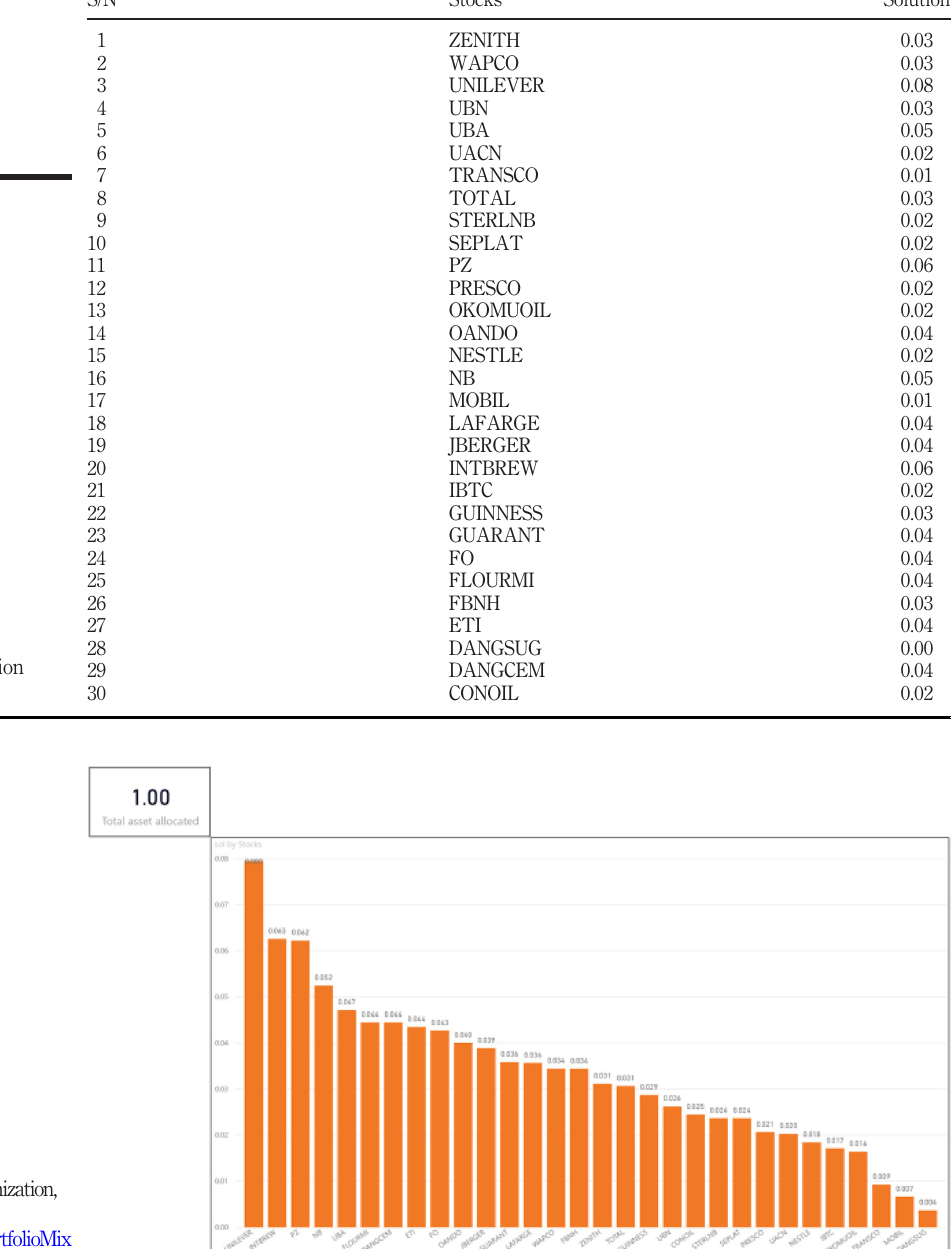
Figure 1. Portfoliooptimization,